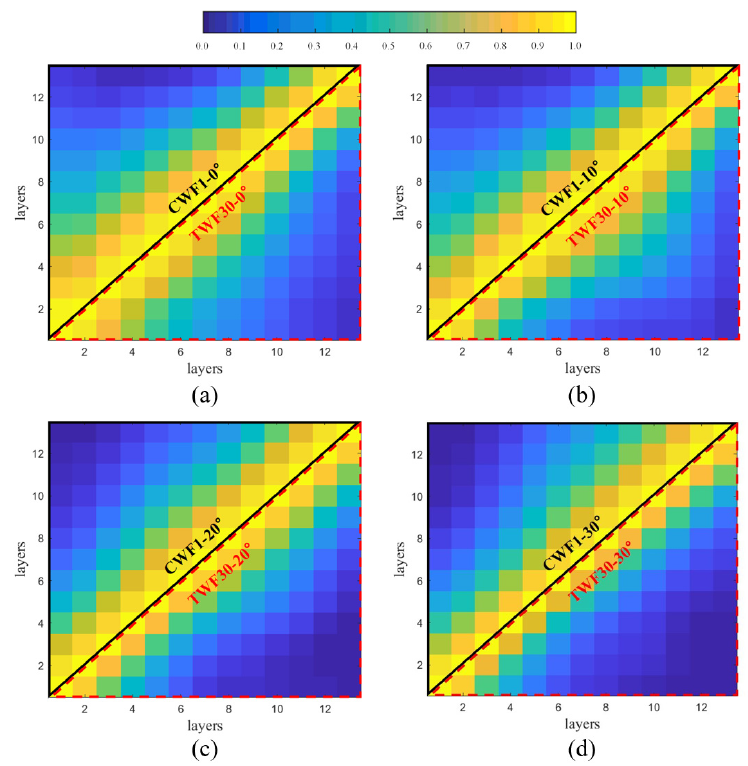
Figure 18. Correlation coefficients of across-wind load among different layers: ( a ) θ ref = 0 ◦ ; ( b ) θ ref = 10 ◦ ; ( c ) θ ref = 20 ◦ ; and ( d ) θ ref = 30 ◦